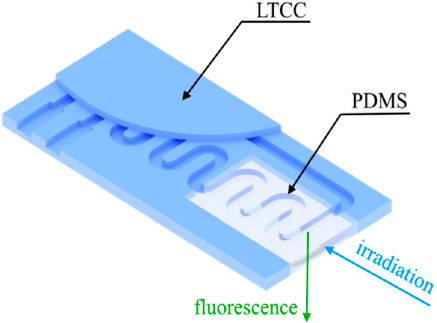
Figure 10. An example of PDMS implementation as both a waveguide and an optical window in a fluorescence sensor.